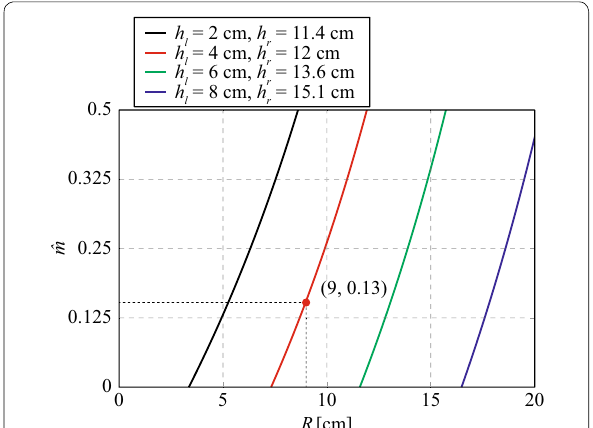
Fig. 7 Relation between R and ˆ m calculated with different pairs of h l and h r that give T l 0.65 =